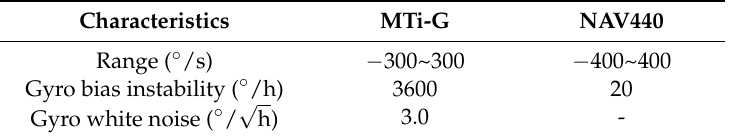
Table 3. Characteristics of tested